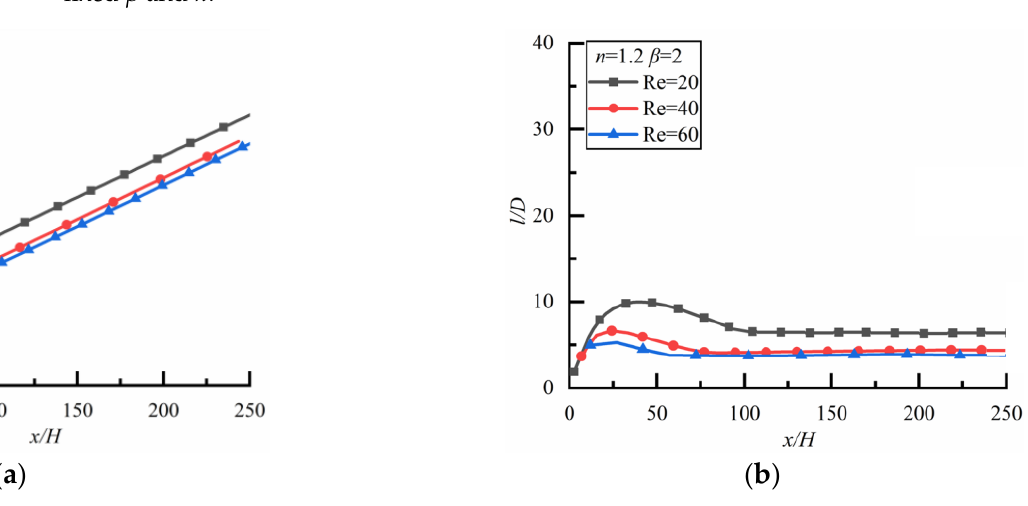
Figure 11. Changes of l/D along flow direction for different Re ( n =1.2). ( a ) β =0.5, ( b ) β =2.